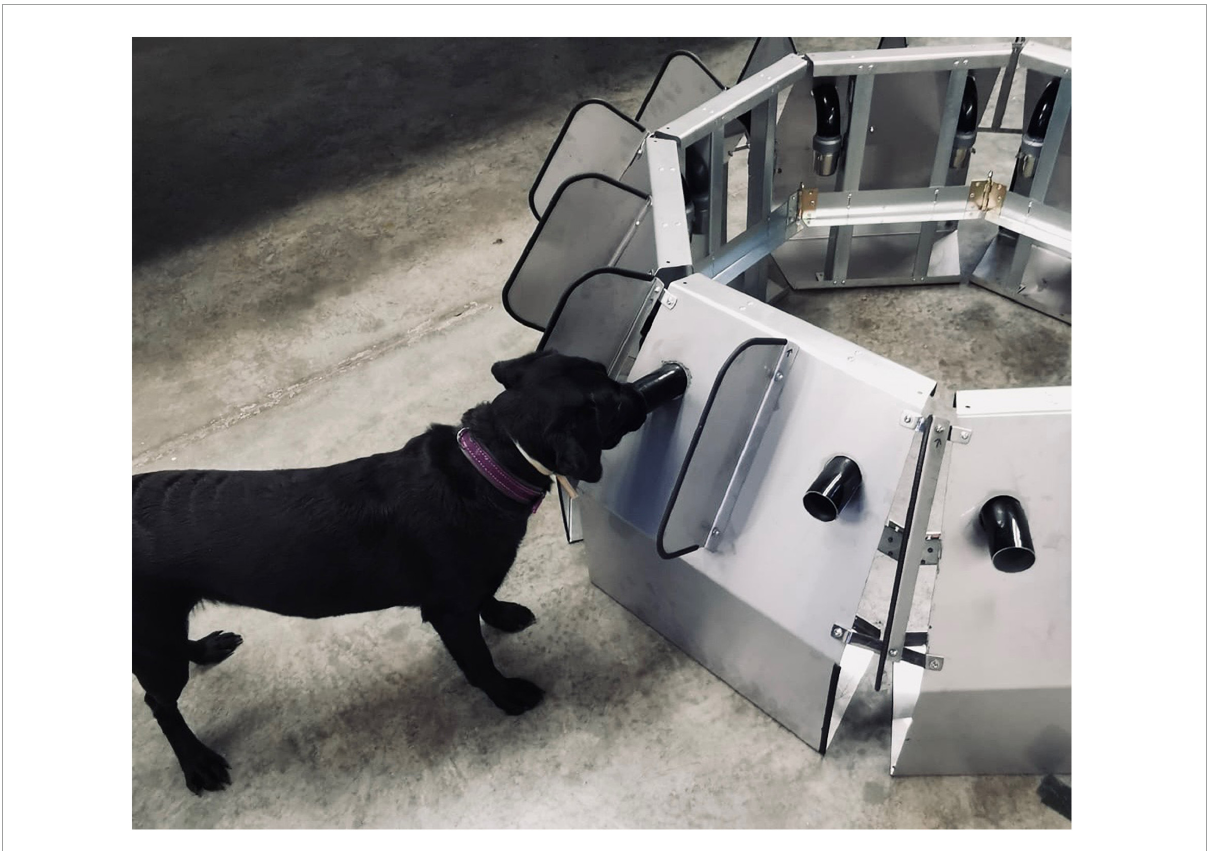
FIGURE3 Dog working at a